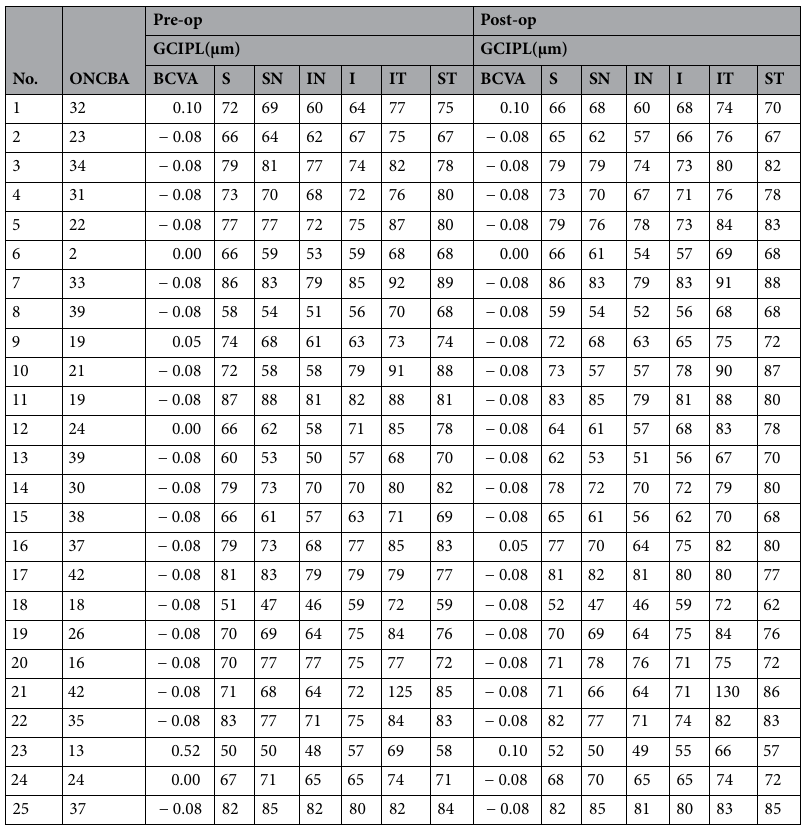
Table 3. Angle of bending and ophthalmologic parameters of patients without optic nerve bending. ONCBA optic nerve–canal bending angle, BCVA best-corrected visual